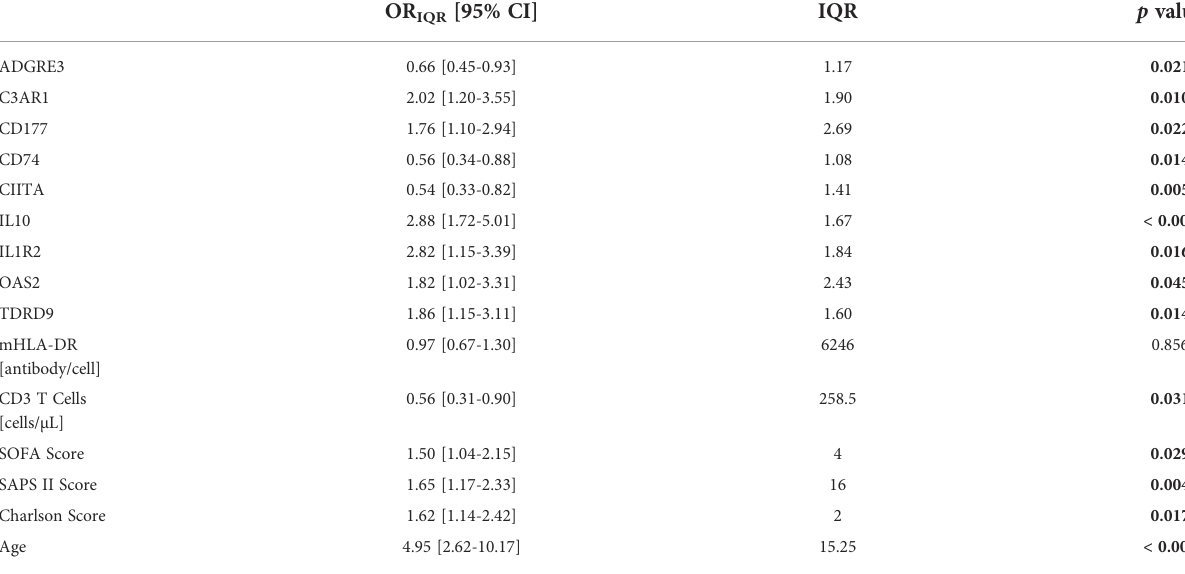
TABLE 2 Association between IPP transcriptomic, immune, clinical or demographical parameters and 28-day survival status: univariate